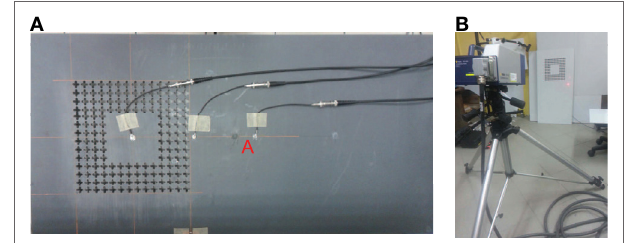
FigUre 9 | (a) In-plane view of the SLDV scanning grid point superimposed on the PVC phononic plate and (B) positioning of the SLDV measurement head.